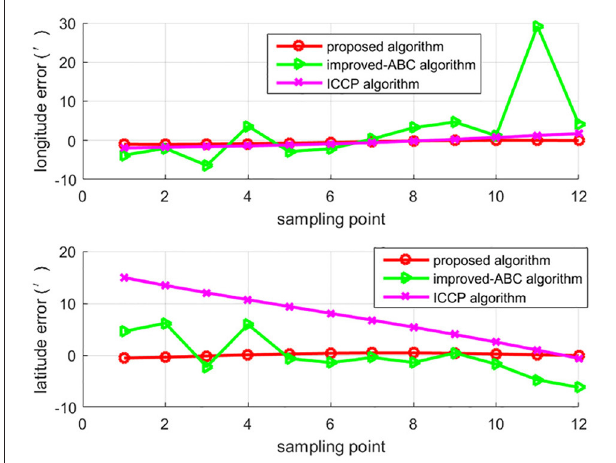
FIGURE 7 | The average error of longitude and latitude.